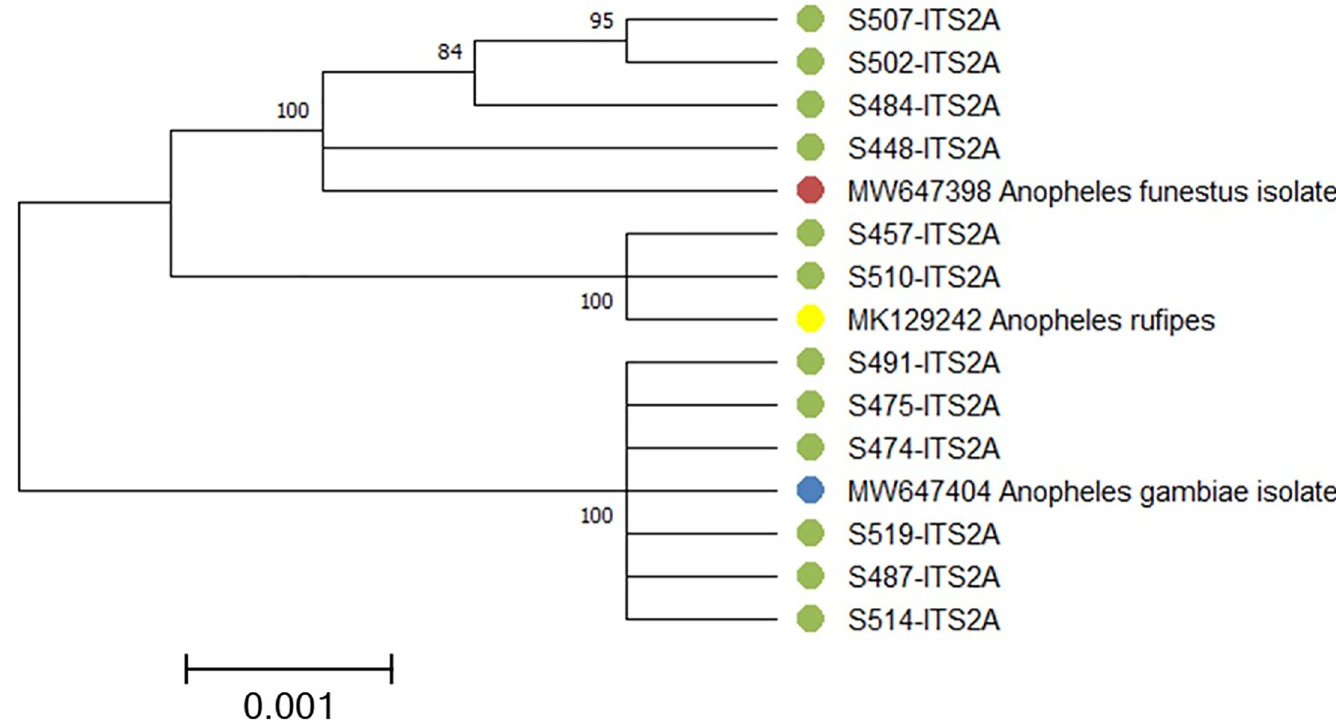
Fig 6. Evolutionary relationships of taxa.